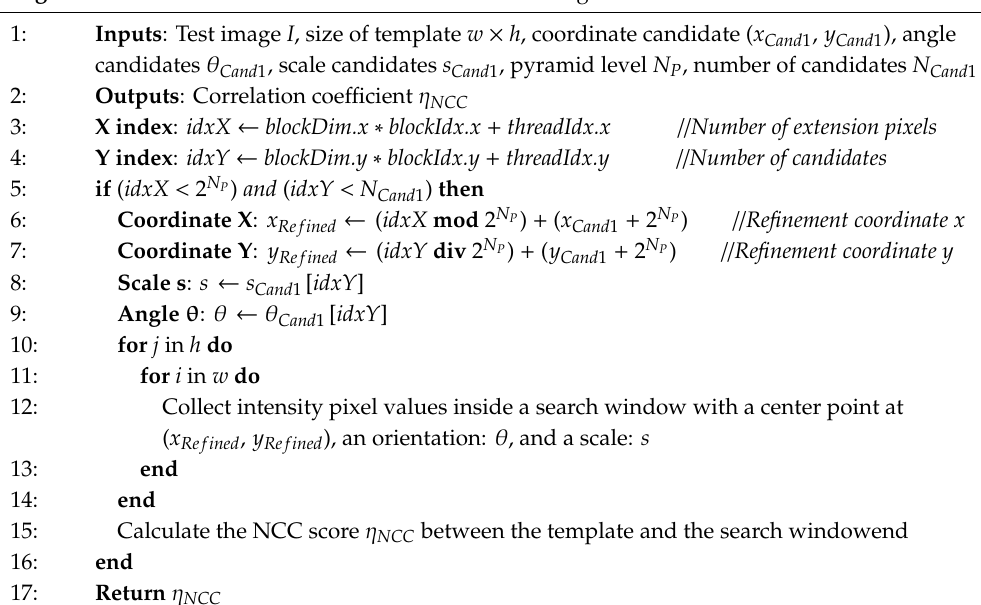
Algorithm 1 Pseudo-code of location refinement